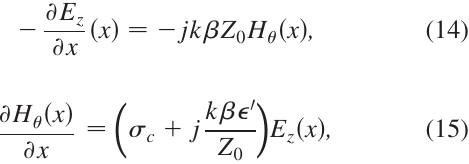
FIG. 2. A wall with thickness t , the conductivity of (cid:1) relative dielectric constant of (cid:8) 0 . The beam runs in region